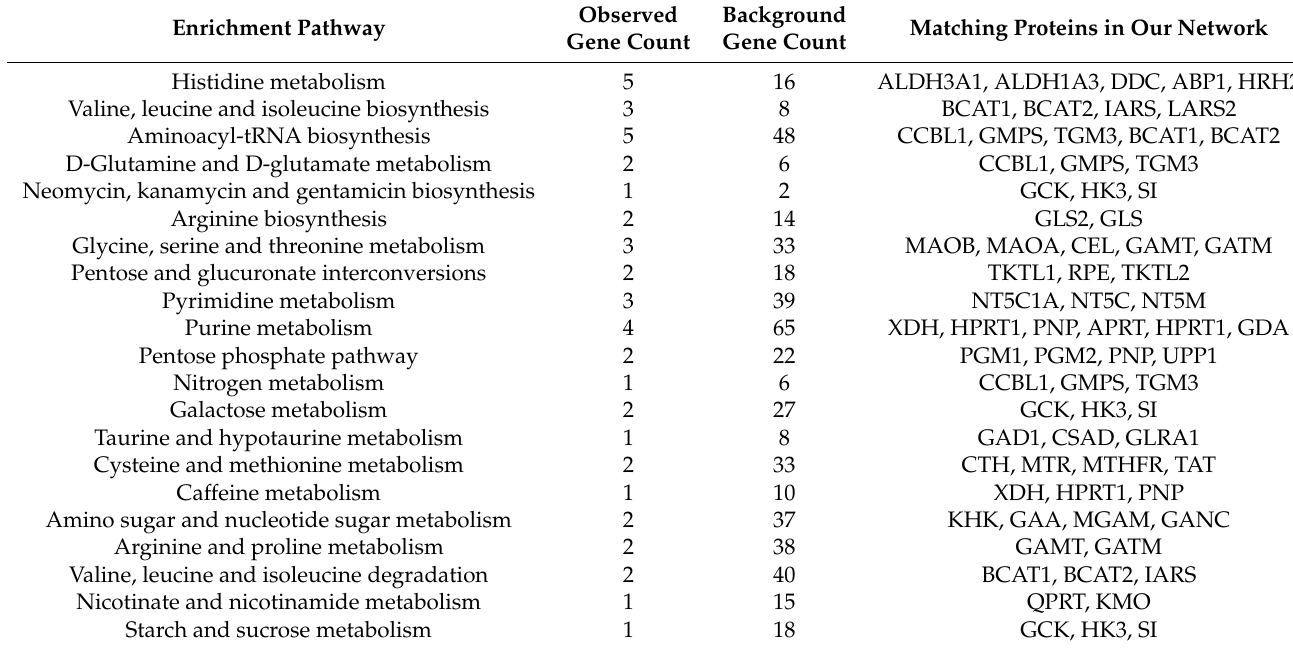
Table 1. KEGG pathway enrichment results of regulatory